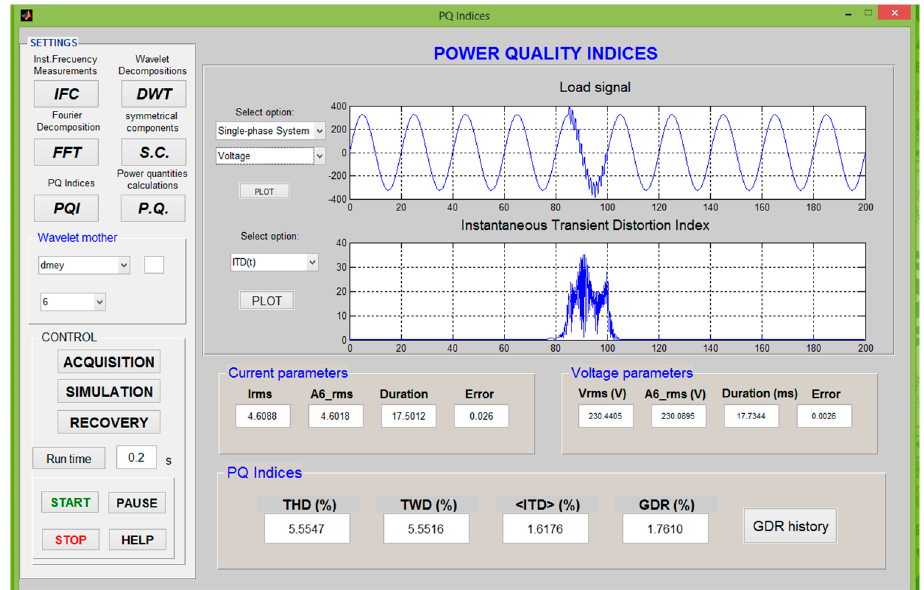
Figure 5. Graphical user interface of the power quality (PQ) System Analyzer.